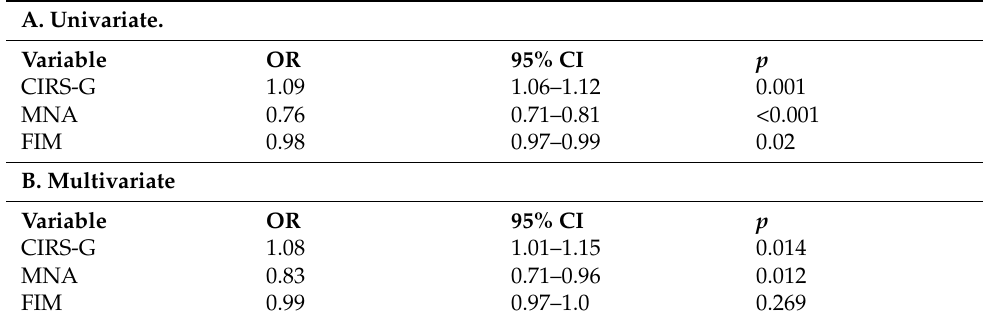
Table 2. Association between scores evaluating comorbidities, malnutrition and functionality and 1-year mortality (univariate and multivariate analysis).